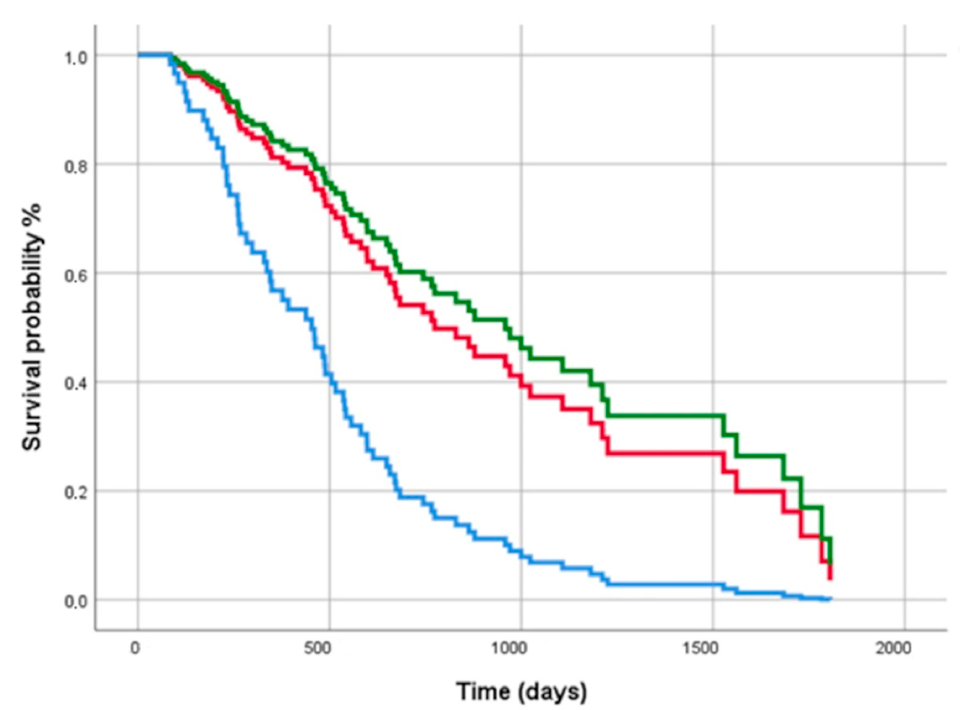
Figure 4. Cox regression analysis for progression free-survival among IPF ( red line ), FPF ( blue line ) and PF-ILD ( green line ) subgroups. The covariates were age, gender, basal FVC < 70% of predicted value and diagnostic